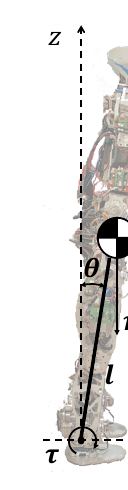
Figure 13. Experimental setup of the TEO